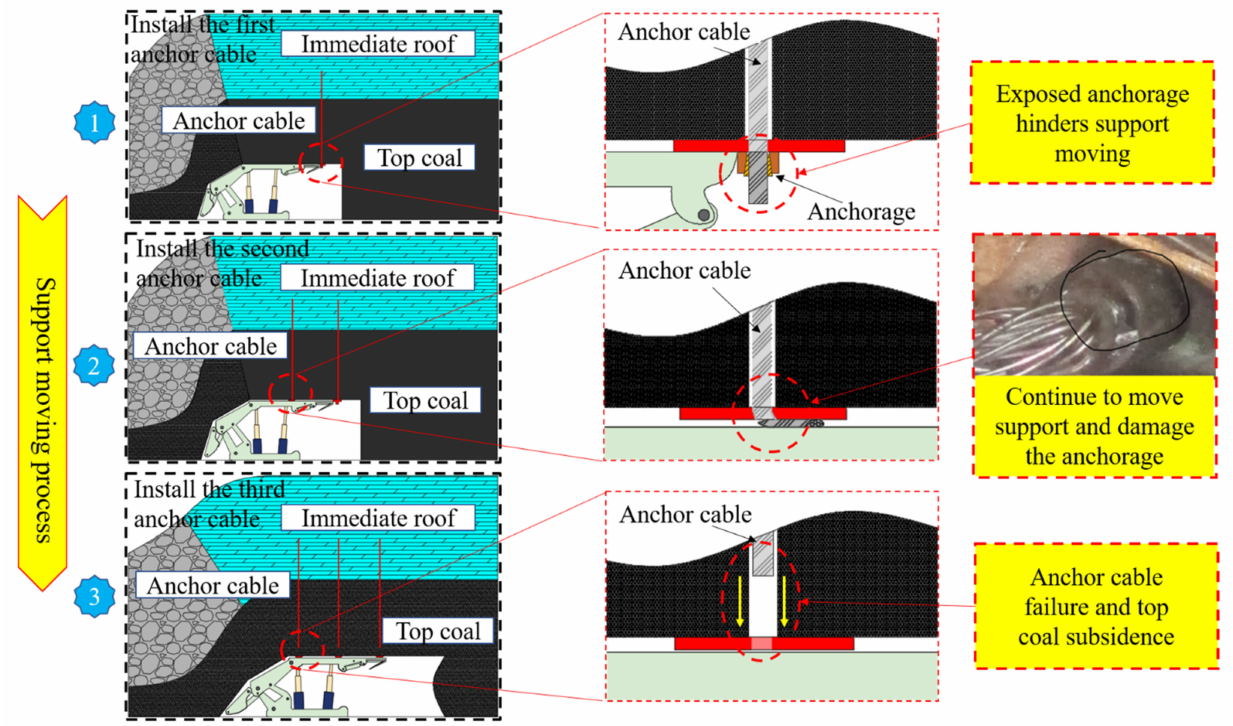
Figure 19. Disadvantages of exposed anchorages of the anchor